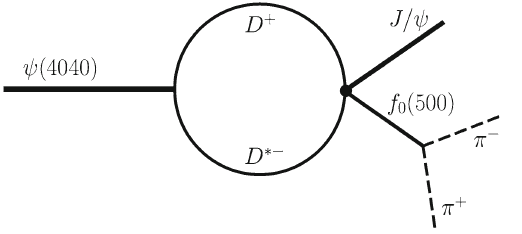
Fig. 4 Schematic diagram of the decay ψ( 4040 ) → π + π − J /ψ via D + D ∗−